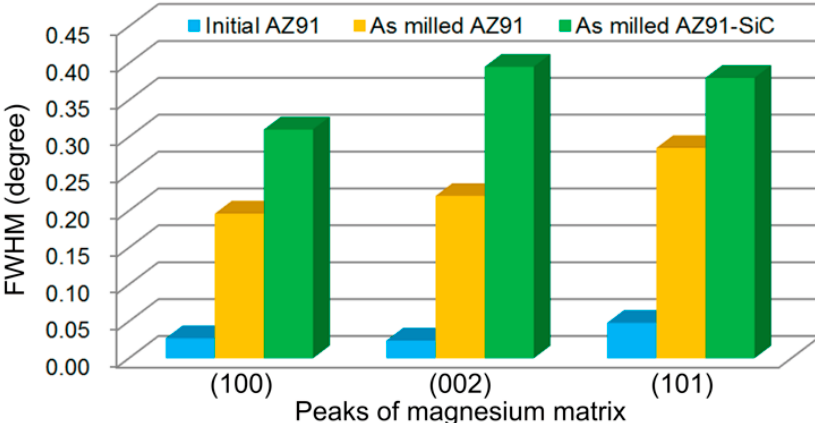
Figure 7. The full width at half maximum (FWHM) values of the three most intensive peaks of the magnesium matrix.